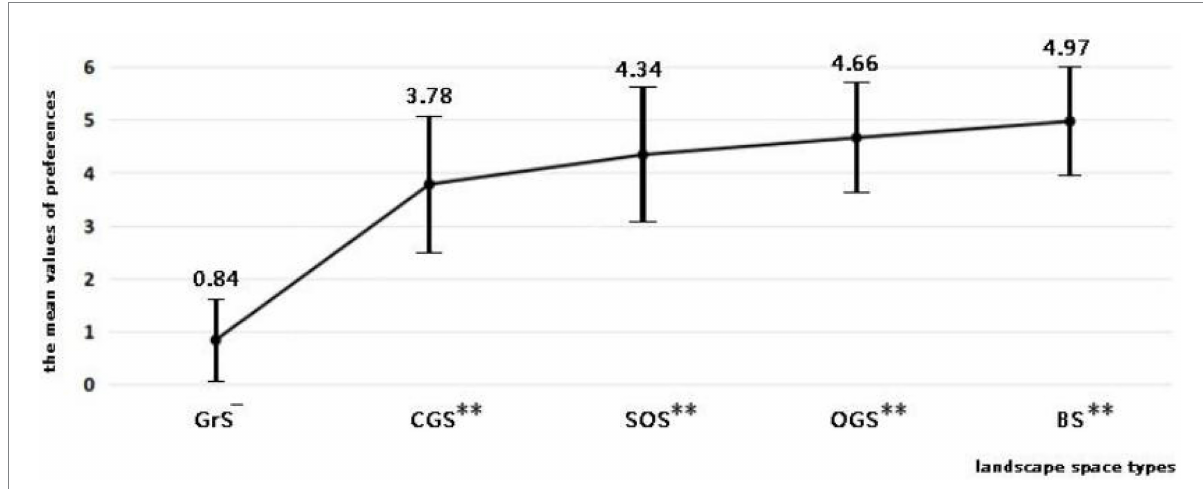
FIGURE 3 Mean values of participants’ preferences for different landscape space types. I. GrS refers to the gray space. CGS refers to the closed green space landscape. SOS refers to the semi-open green space landscape. OGS refers to the open green space landscape. BS refers to the blue space landscape. II. — refers to the reference landscape. ** refers to the significant difference between the landscape and the reference landscape ( p <